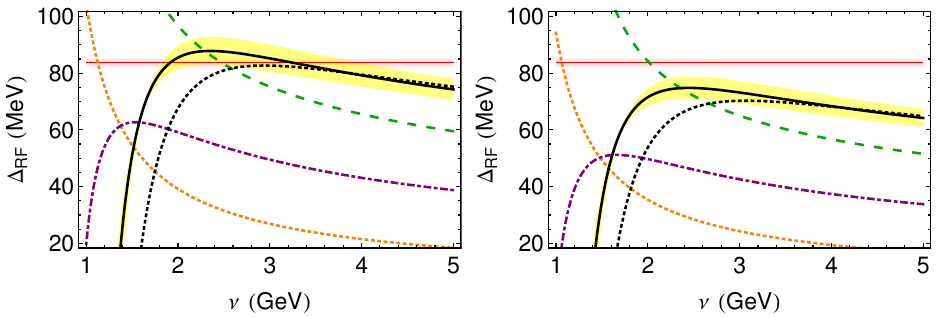
Figure 5 . Plots of (cid:1) RF = M B (cid:0) M (cid:17) = 2 (cid:0) M (cid:17) = 2 with (cid:23) f = 1 GeV, m b; RS = 4 : 618 GeV, m c; RS = c c b 1 : 209 GeV, m b; RS 0 = 4 : 885 GeV, m c; RS 0 = 1 : 496 GeV. Red line is experimental value. Orange dotted, purple dot-dashed and green long-dashed are the LO-NNLO contributions respectively. Solid black line is the N 3 LO, and the dotted black line the N 3 LO without (cid:14)E US . The yellow band 10 represents the error coming from (cid:11) s ( M z ) = 0 : 1184(12). Left panel: plot of (cid:1) RF in RS scheme. Right panel: plot of (cid:1) RF in RS’